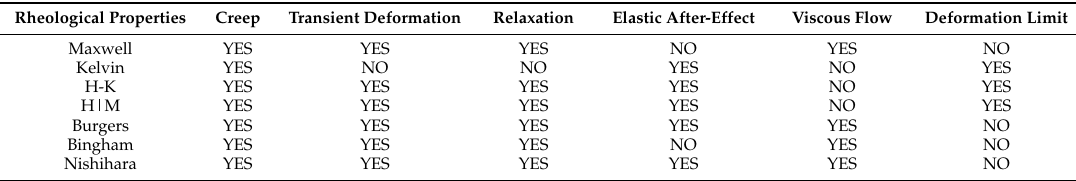
Table 2. Creep properties described by different rheological models.